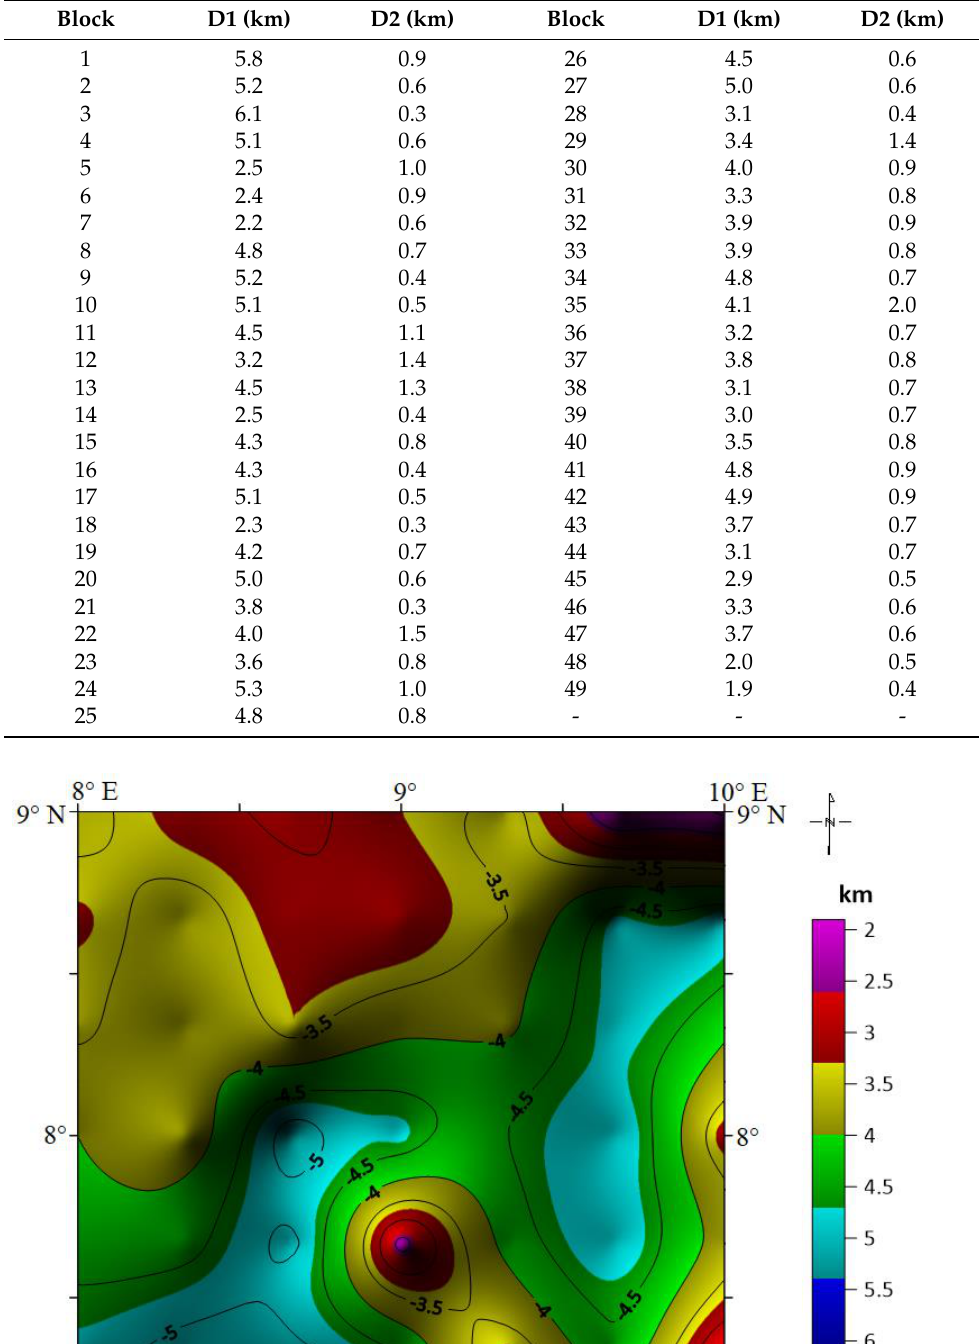
Table 1. Results of the deeper (D1) and the shallower (D2) magnetic sources for the blocks displayed in Figure 5a.